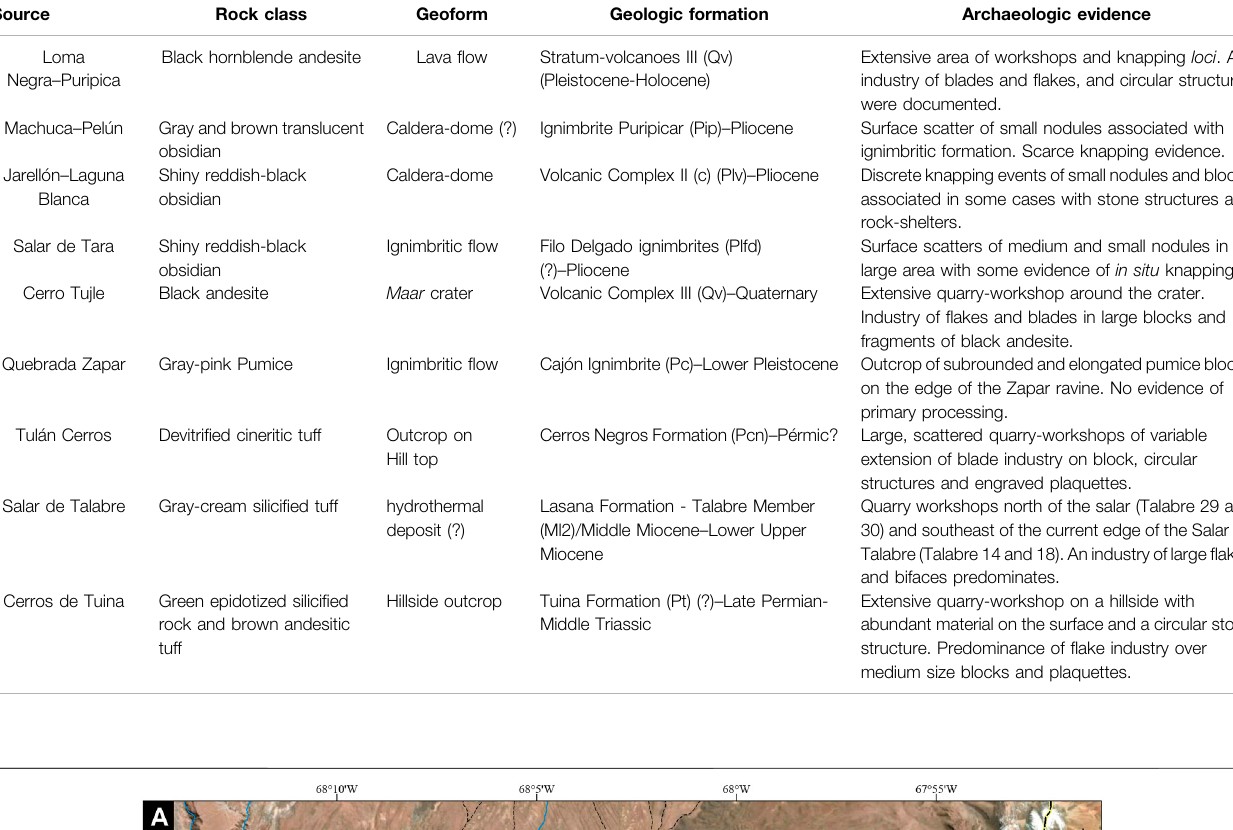
TABLE 3 | Sources of lithic procurement identi fi ed in the Atacama basin.